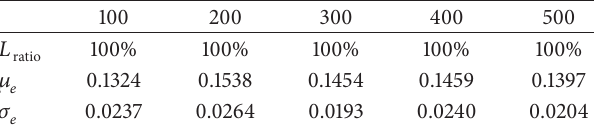
Table 2: Scalability of MAALRH